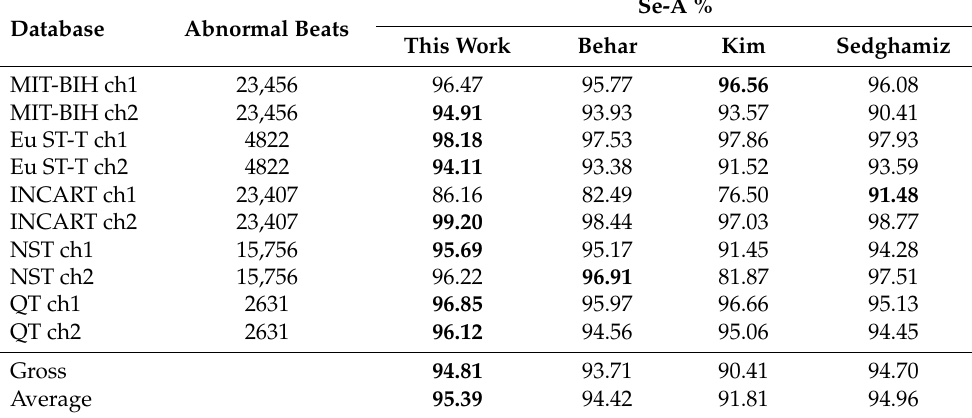
Table 3. QRS detection Se-A